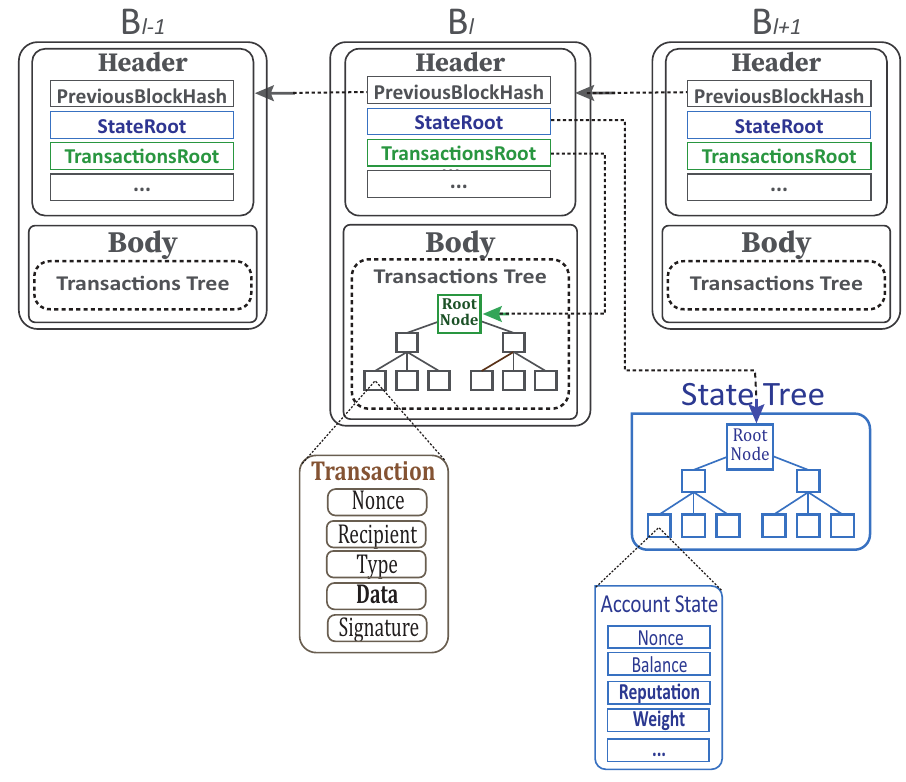
Figure 2. Blockchain components with the